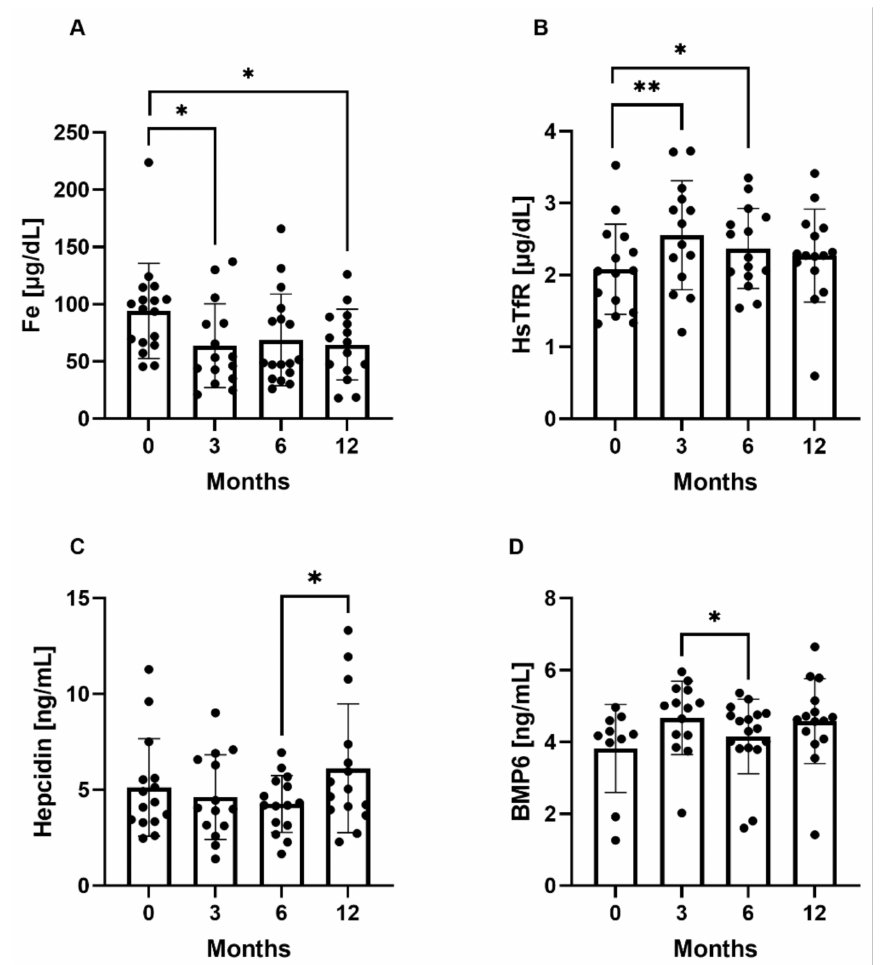
Figure 2. Iron homeostasis parameters at the study time points. ( A ) Mean iron (Fe) concentration at the study time points. ( B ) Mean human soluble transferrin receptor (HsTfR) at the study time points, ( C ) Mean hepcidin concentration at the study time points. ( D ) Mean bone morphogenetic protein-6 (BMP-6) concentration at the study time points. * p < 0.05, ** p < 0.01 (paired t